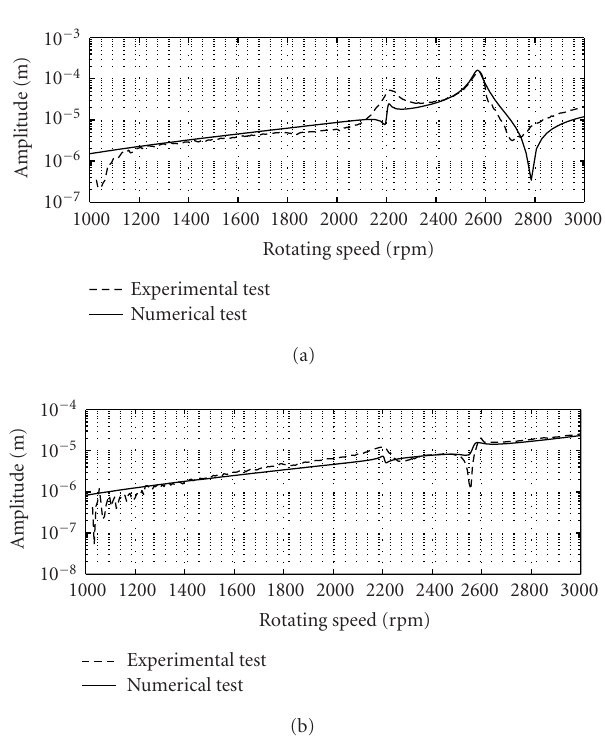
and E forward are less than 0 . 9 percent and 2 . 2 percent at the first backward and forward critical speeds, respectively.